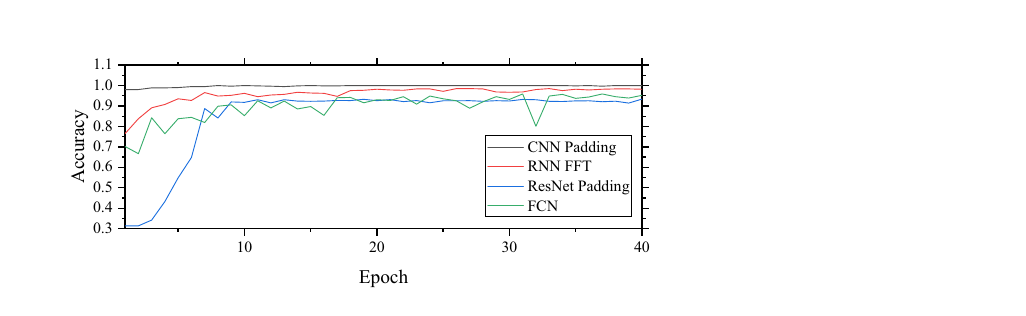
Figure 8. Accuracies of testing data on unsupported sleeper